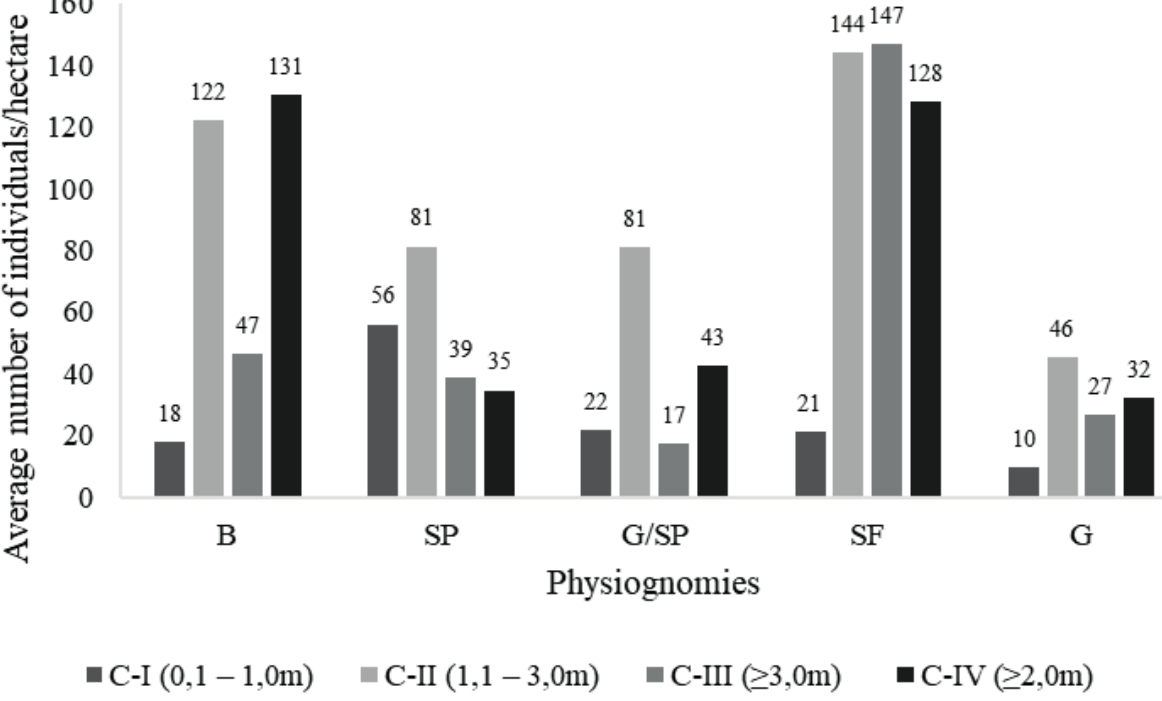
Figure 2. Average number of individuals/hectare found in the height classes I (0.1 - 1.0m), II (1.1 - 3.0m), III (≥ 3.0m) and IV (≥ 2.0m) for the physiognomies of Backyard (B), Savannah Park (SP), transition between Savannah grassland and Savannah Park (G/SP), Secondary Forest (SF), and Savannah grassland